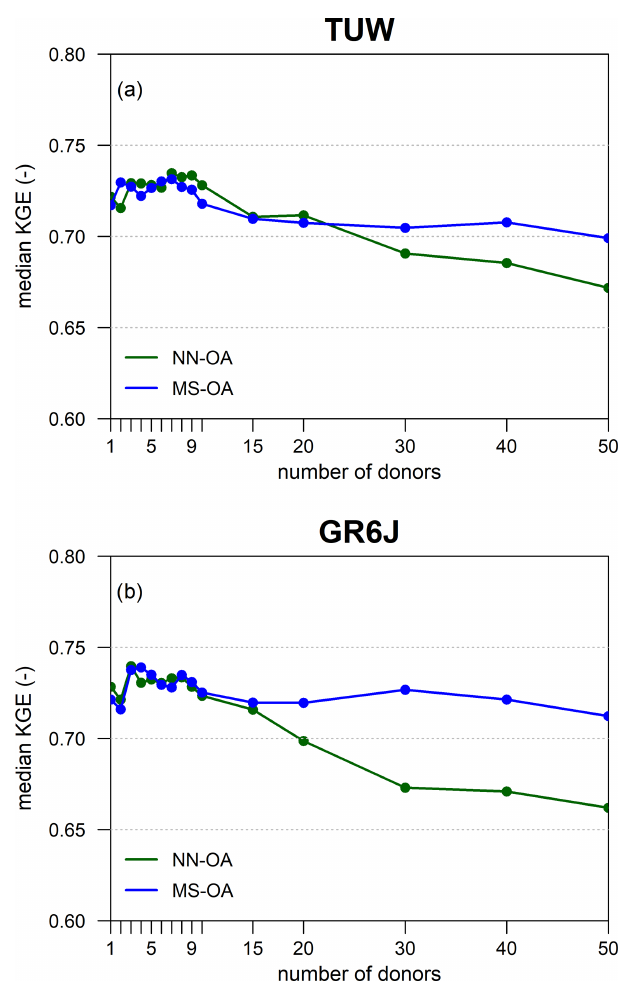
Figure 6. Impact of the number of donors on output-averaging near- est neighbour (NN-OA) and most similar (MS-OA) regionalisation methods for TUW (a) and the GR6J (b)